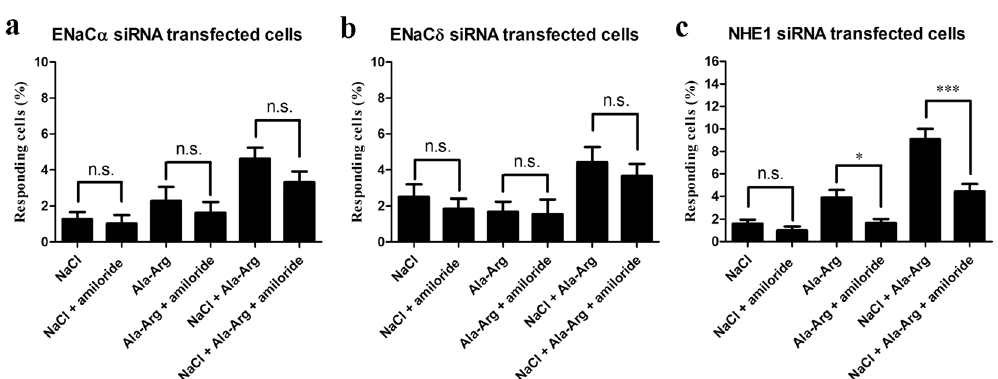
Figure 8. Effects of amiloride on NaCl (150 mM), Ala-Arg (AR; 50 μ M), and the mixture of NaCl and AR in ENaC α ( a ), ENaC δ ( b ), and NHE1 ( c ) siRNA-transfected HBO cells. Responding cells were measured by intracellular Ca 2 + changes. The concentration of amiloride was 50 μ M. Each experiment was performed seventeen times. * p < 0.05, ** p < 0.01, *** p < 0.001, n.s., not